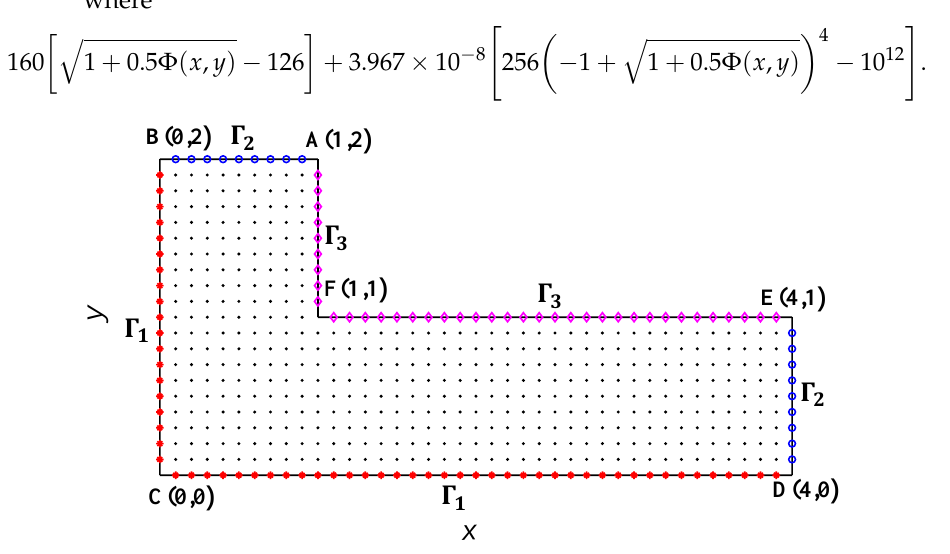
Figure 4. Schematic of the computational domain of case 2.